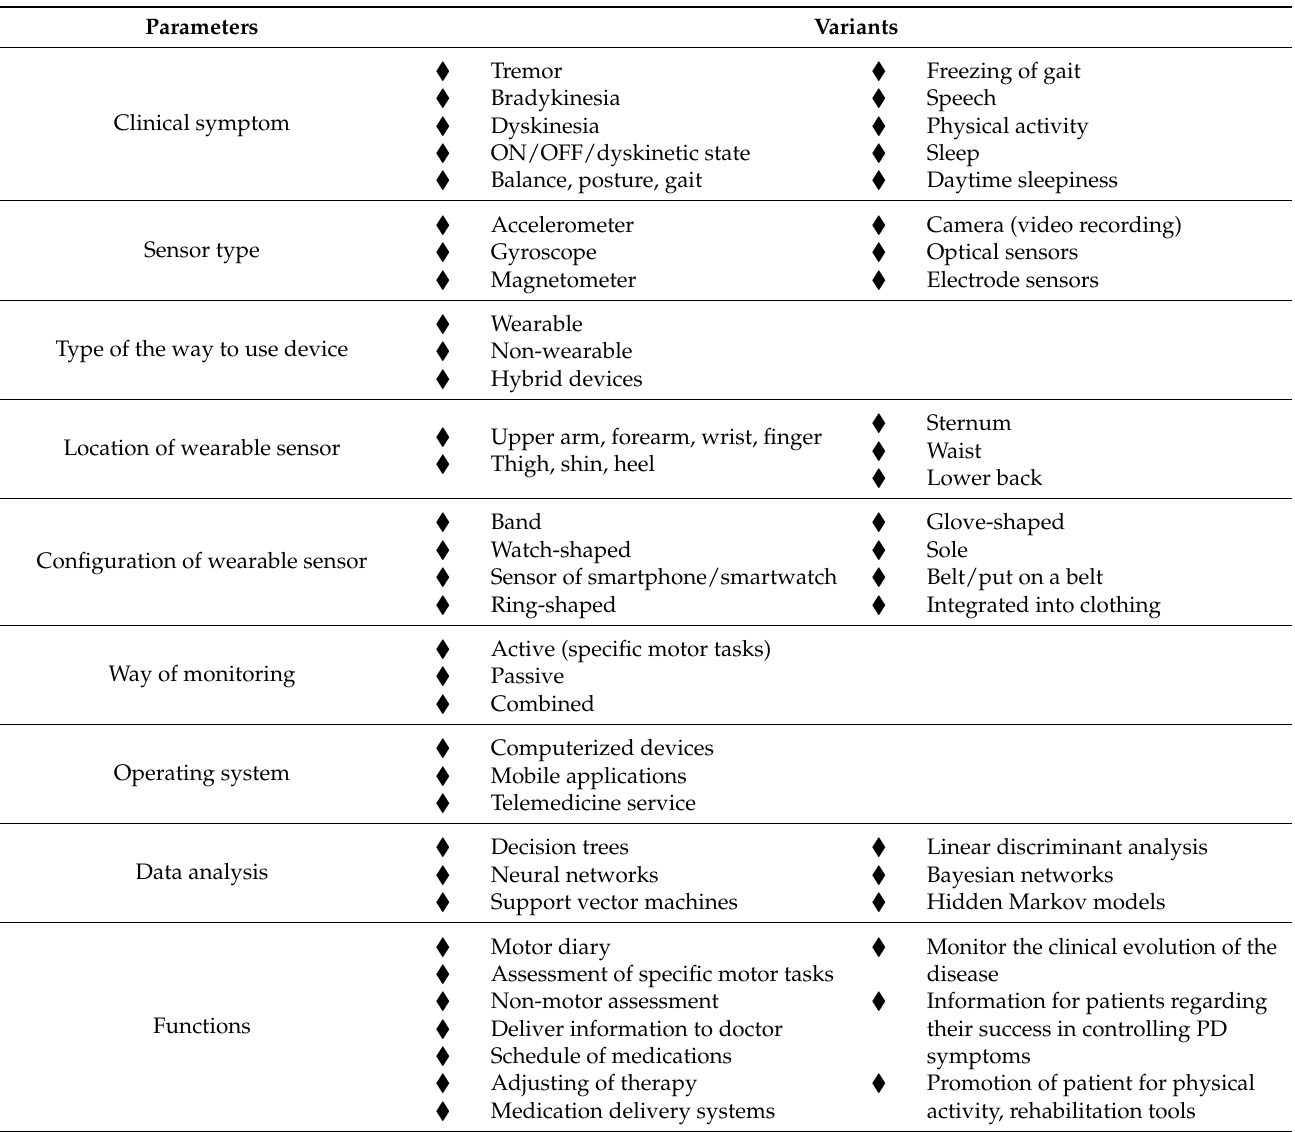
Table 1. Parameters of technology-based